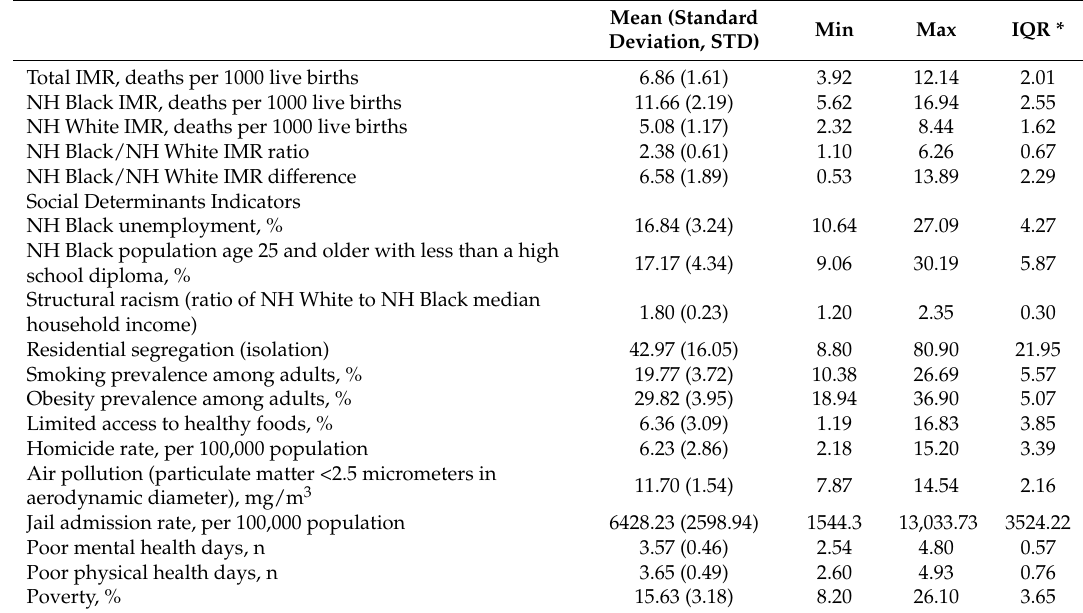
Table 2. Descriptive statistics for 100 MSAs included in